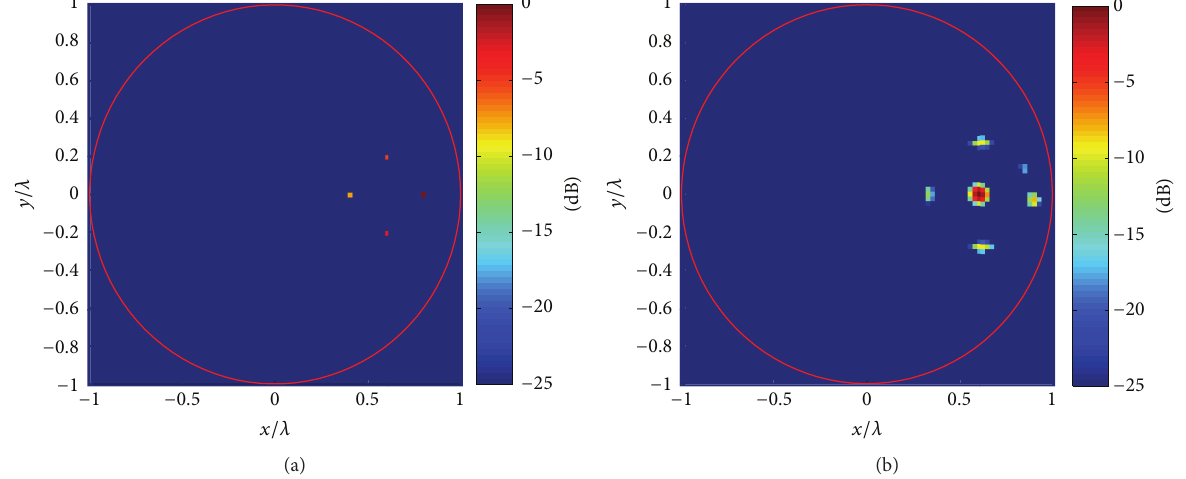
Figure 13: Comparing TRM (a) and CS (b) normalised reconstructions with noiseless